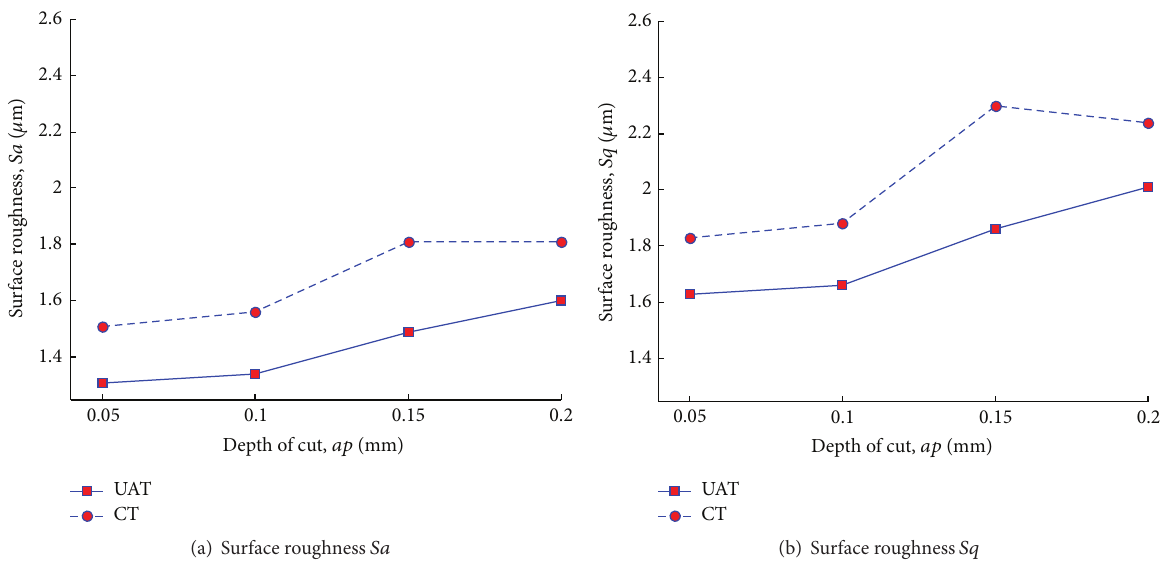
Figure 19: Relation curve of surface roughness changed with depth of